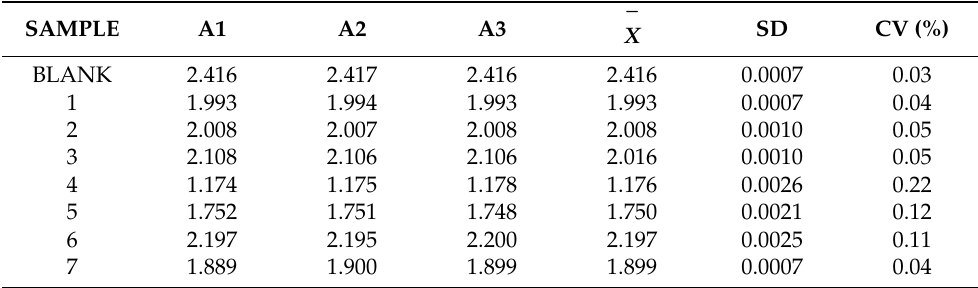
Table 1. Absorbances obtained for hydrophilic extracts of cream samples (DPPH method).